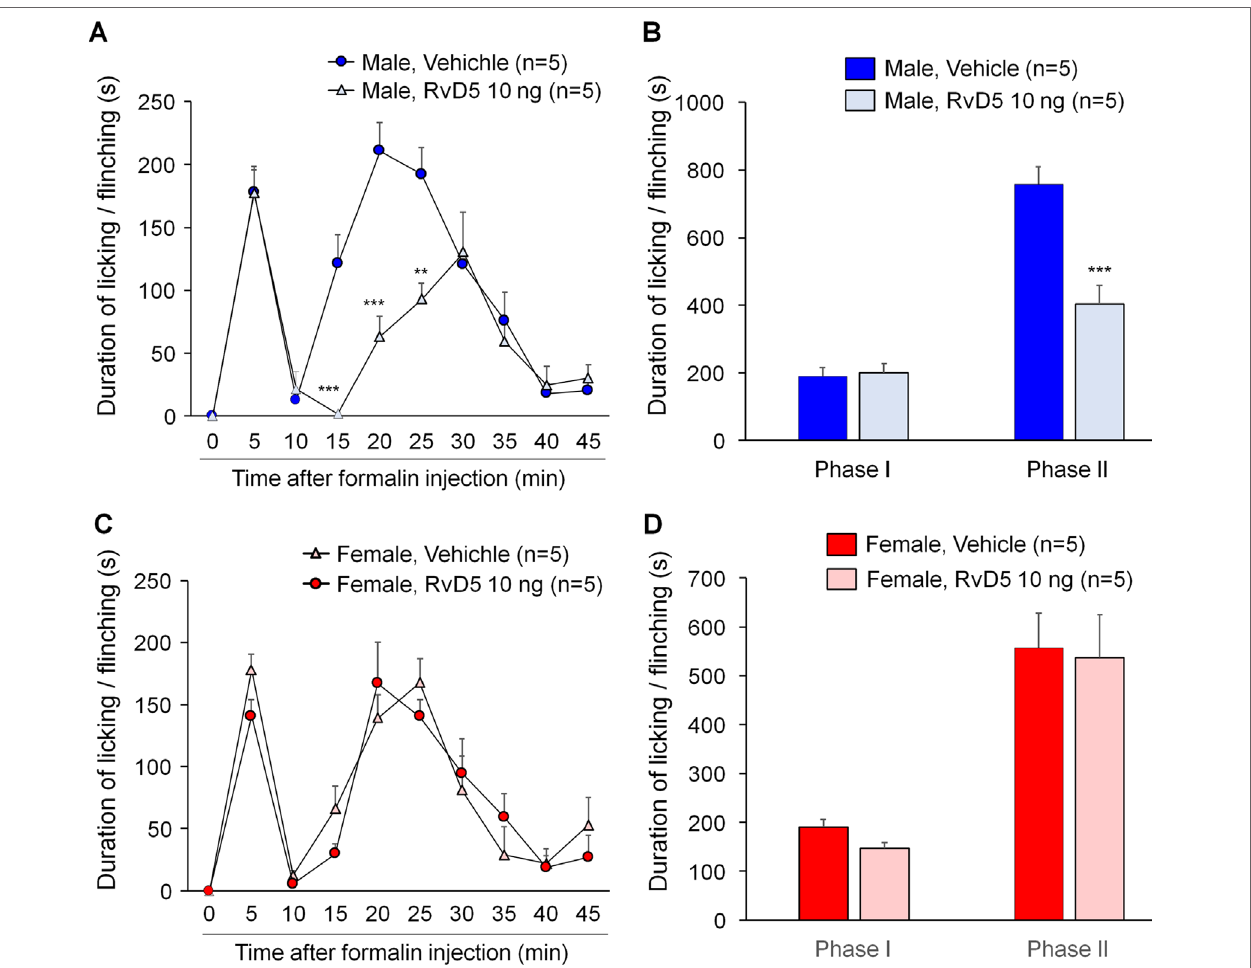
FIGURE 4 | Intrathecal RvD5 reduces formalin-induced inflammatory pain in male mice (A, B) but not female mice (C, D) . (A, C) Time course of formalin-induced pain in males (A) and females (C) with intrathecal vehicle or RvD5 (10 ng), given 30 min prior to formalin injection. (B, D) Phase I (0-10 min) and Phase II (10-45 min) responses in males (B) and females (D) . Note that RvD5 only inhibits Phase II response in males but has no effect on Phase I response in both sexes. **p < 0.01, ***p < 0.001 versus vehicle group. Two-way ANOVA with Bonferroni’s post hoc test, n = 5 mice per sex per